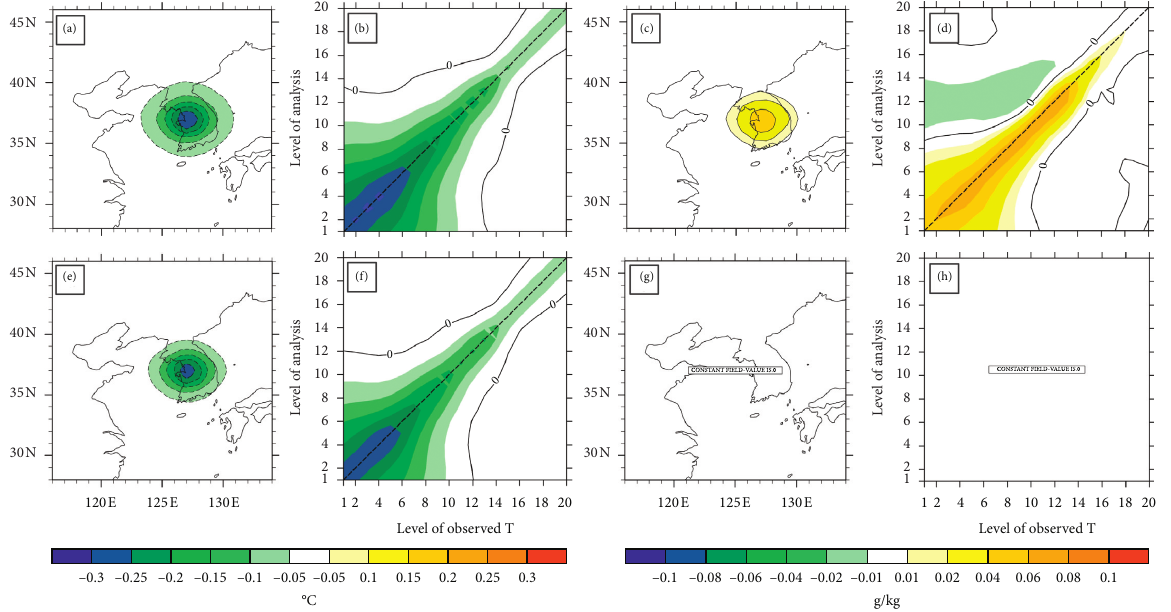
Figure 6: Analysis increments in the single-observation experiments for CV6 (upper row) and CV5 (lower row): horizontal distribution of analysis increments of temperature (a, e) and mixing ratio (c, g) at the bottom model level when the single observation is at the same level; analysis increments of temperature (b, f) and mixing ratio (d, h) at individual levels (vertical axis) when the single observation is specified at each level (horizontal